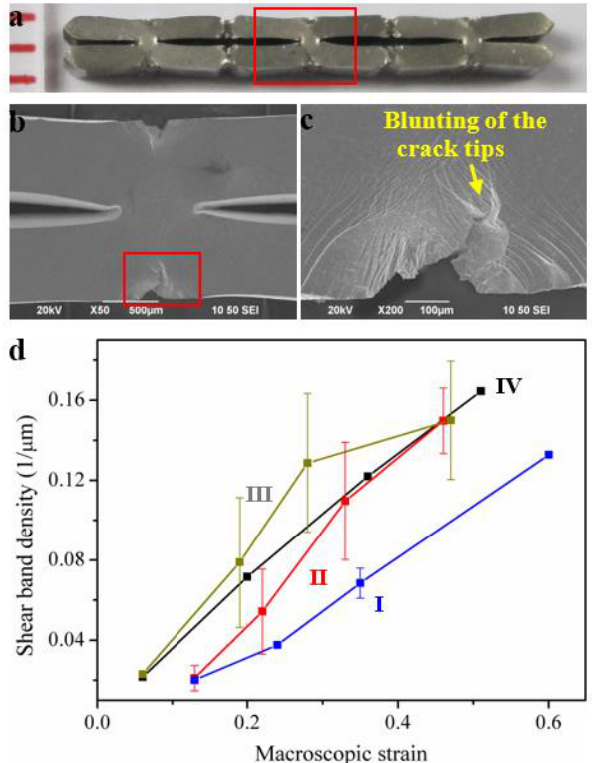
Figure 5. ( a ) The optical image of a cellular MG after densification, where the original square-shaped pores are nearly eliminated. ( b ) The SEM image of a deformed node indicated by the red rectangle in ( a ) at a higher magnification. ( c ) Blunting effect of the propagation of a crack as indicated by the red rectangle in ( b ). ( d ) The evolution of the shear band densities at the nodes of four specimens, I-IV [71].